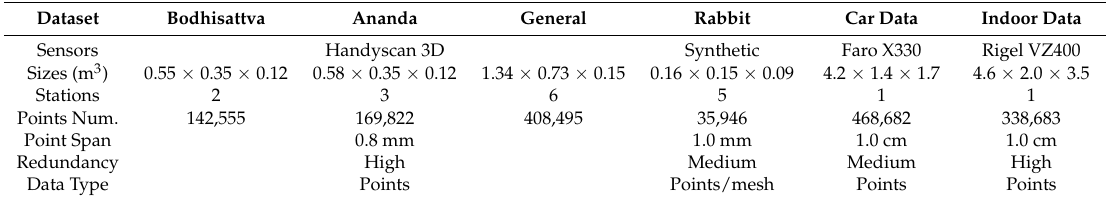
Table 2. Details of experimental datasets.